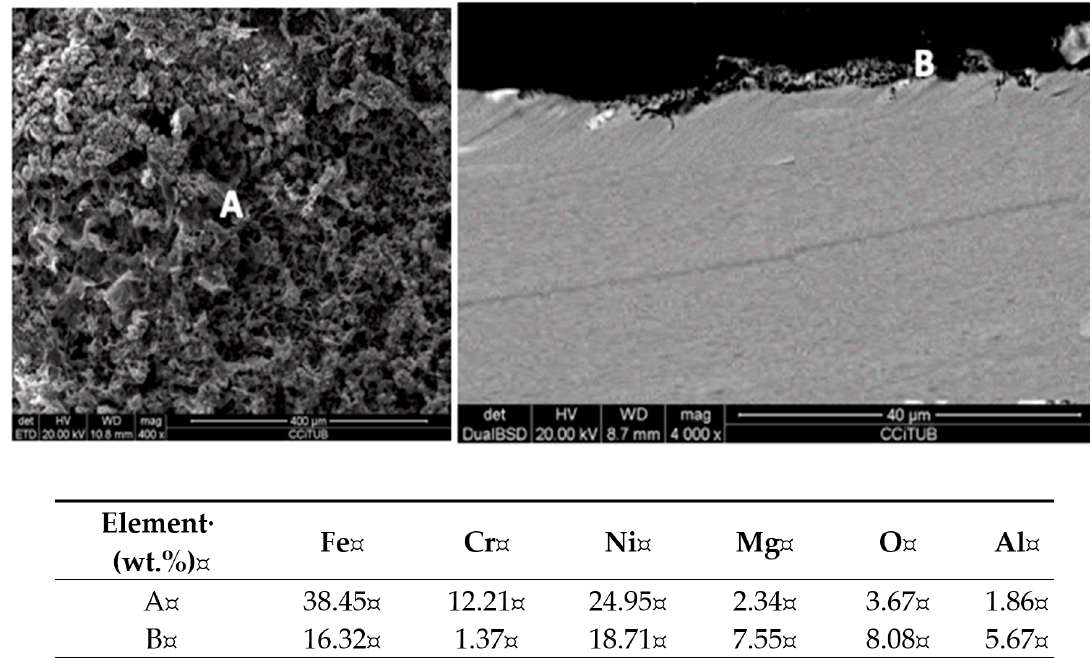
Figure 3. Top view ( left ) and cross-section; ( right ) images for OCT immersed in chloride molten salt for 50 h at 720 °C including energy dispersive X-ray (EDX) analysis (A–B). OCT alloy was previously tested [14] for 8 h of immersion in the same chloride molten salt.